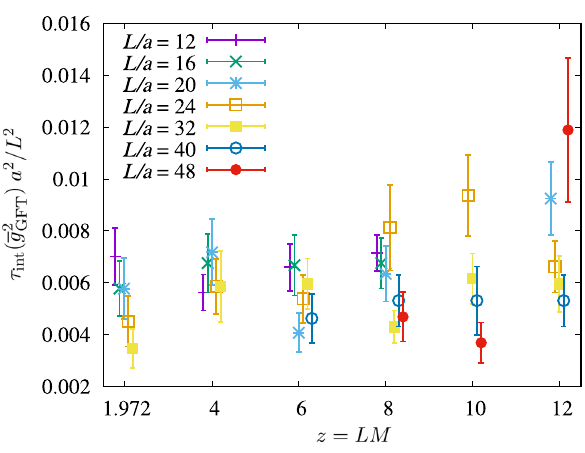
) of the gradient flow GFT